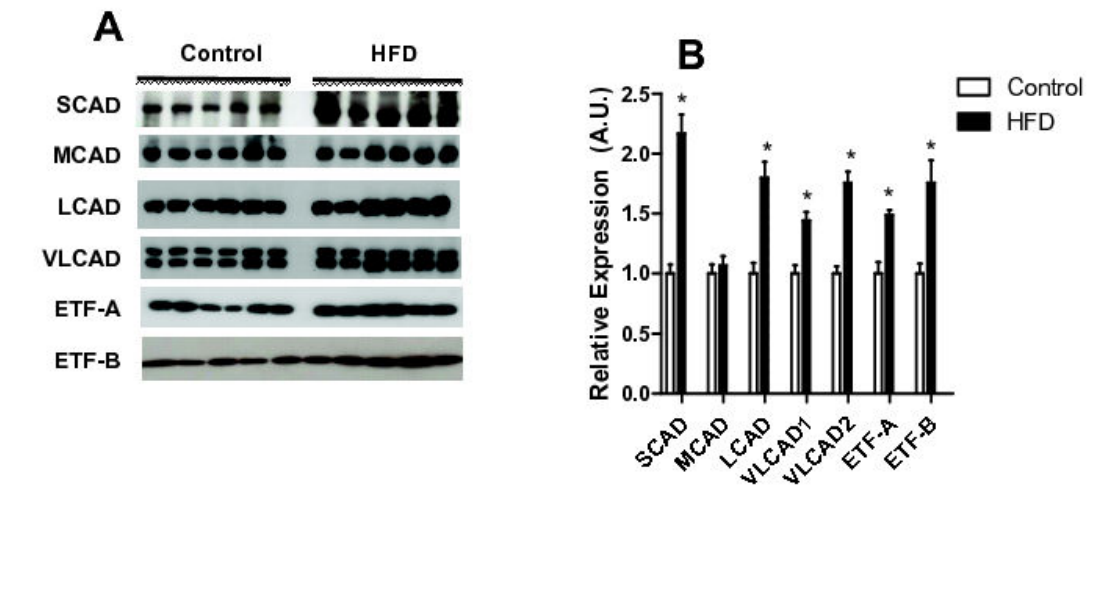
Figure 5. HFD increases the expression of acyl-CoA dehydrogenases isoforms and electron transfer flavoprotein (ETF). Mitochondrial acyl-CoA dehydrogenases and ETF subunits A and B (A-B), were quantified by western blotting as described in Materials and Methods. (A) Representative blots (note that VLCAD has two isoforms), (B) averages ± SEM of densitometries. Where indicated *, p < 0.05 versus control, n = 6 per